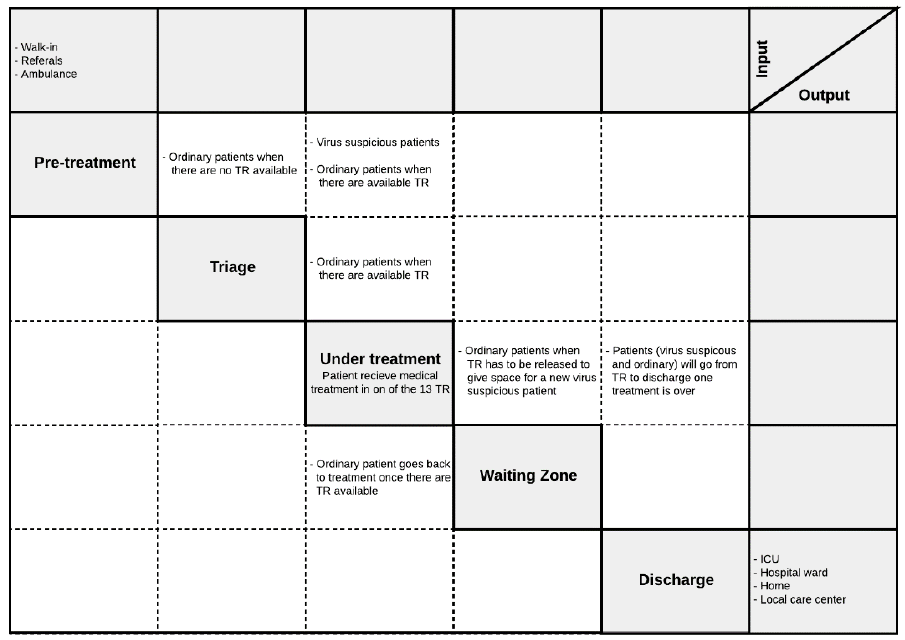
Figure 11. N2 diagram for ED facilities under pre- and peri-pandemic conditions.